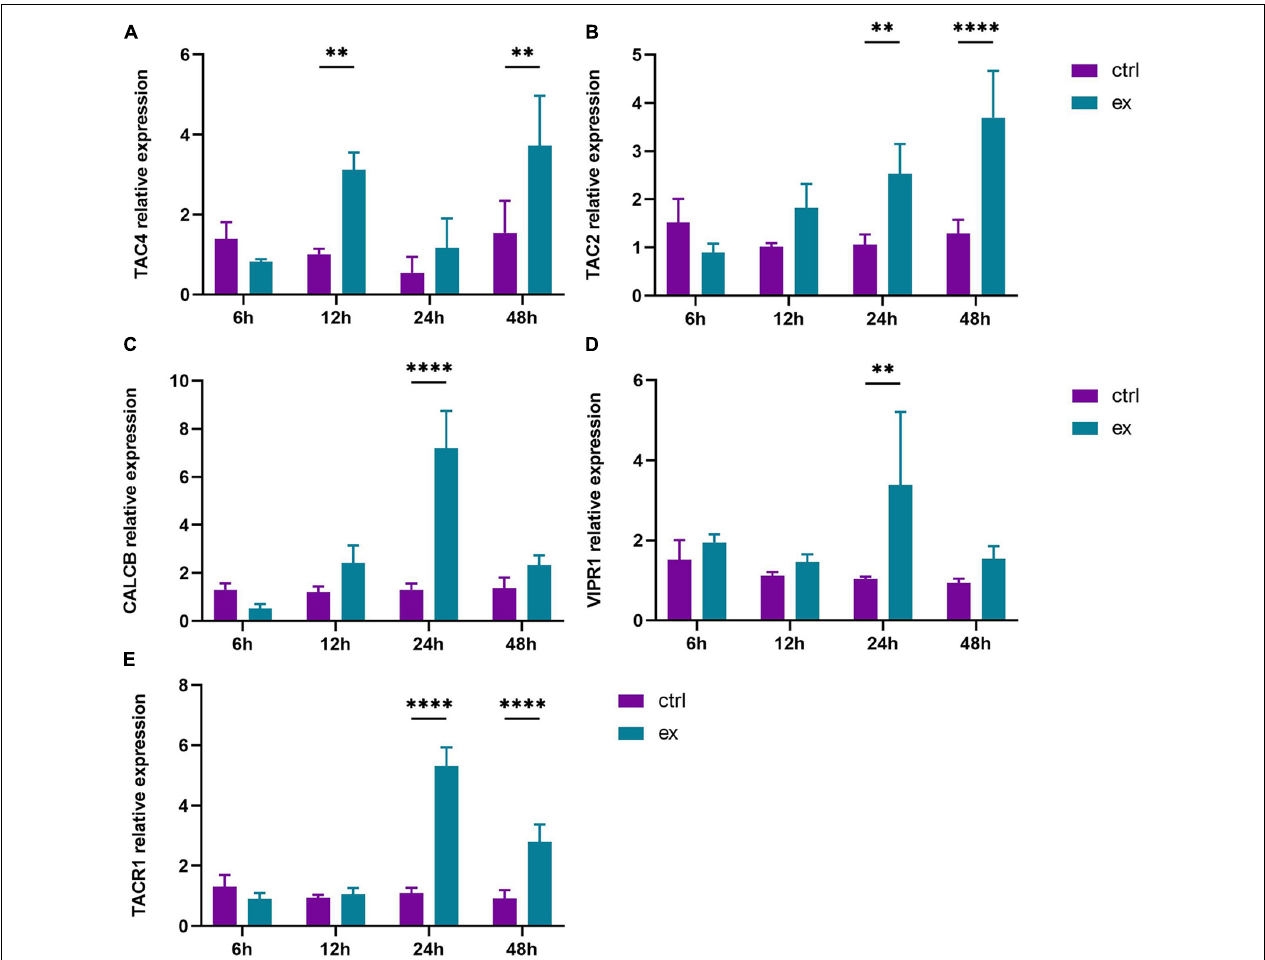
FIGURE 4 | UC-MSC-Exo promote skin fibroblasts to secrete neural factors. The mRNA expression levels of TAC4 (A) , TAC2 (B) , CALCB (C) , VIPR1 (D) , TACR1 (E) , which were quantified by quantitative real-time RT-PCR. ** p < 0.01, **** p < 0.0001. Error bars indicate SDs of triplicate samples in a single representative